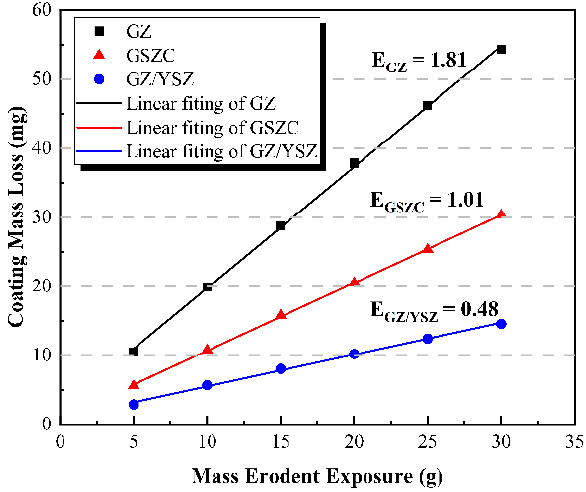
Figure 9. Coating mass loss as a function of erodent exposure for GZ, GZ/YSZ, and GSZC TBC sam- ples.